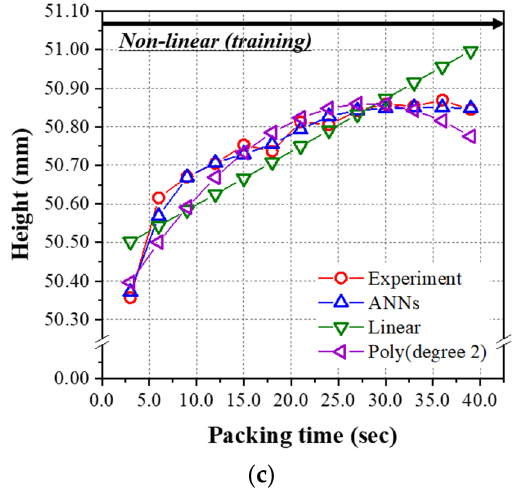
Figure 14. Predicted heights of the nonlinear group from Table A2 using the models learned by the nonlinear group (packing time was 3.0–39.0 s). Melt temperatures were ( a ) 200 °C, ( b ) 220 °C, and ( c ) 240 °C.